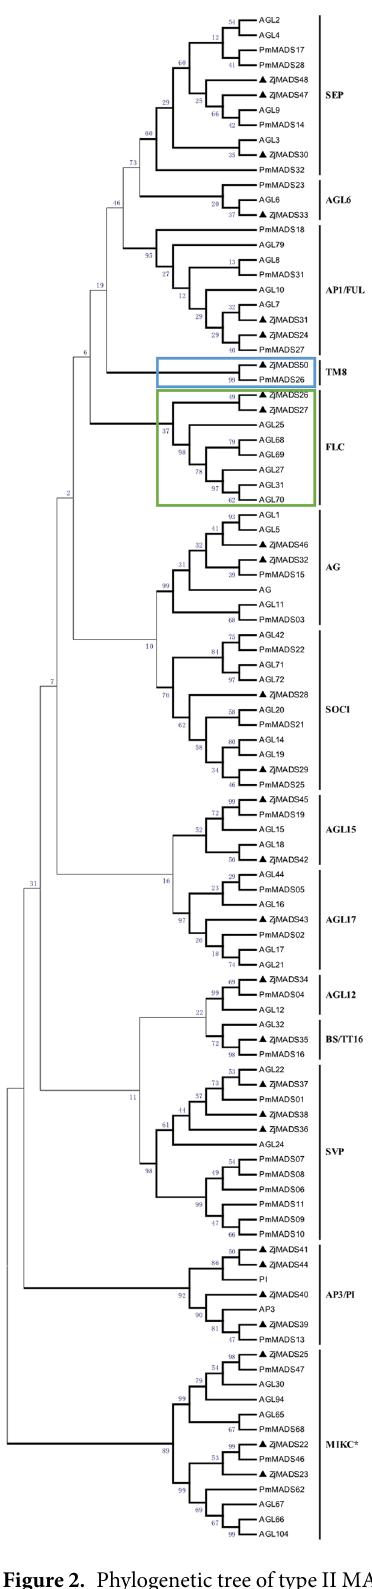
Figure 2. Phylogenetic tree of type II MADS-box genes in Z . jujuba , P . mume and Arabidopsis . The tree was generated using the neighbor-joining method implemented in MEGA 5.1. The FLC subfamily (absent in P . mume ) and the TM8 subfamily (absent in Arabidopsis ) are shown in frame